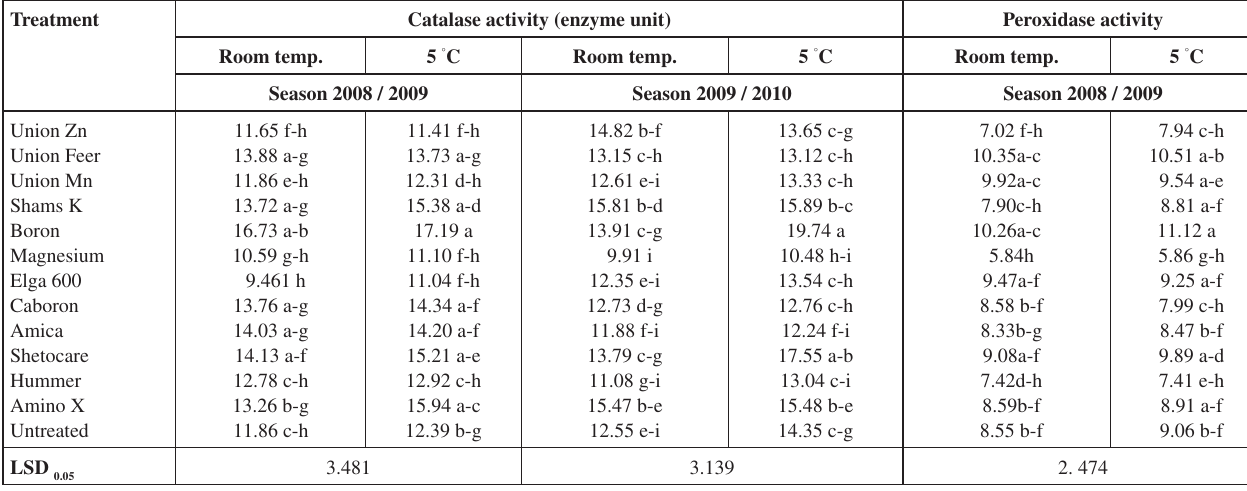
Table 17b: Effect of the interaction between storage temperature and foliar application with commercial compounds on peroxidase and malondialdehyde content of onion seeds during growing seasons Treatment Malondialdehyde content Peroxidase activity Room temp. 5 °